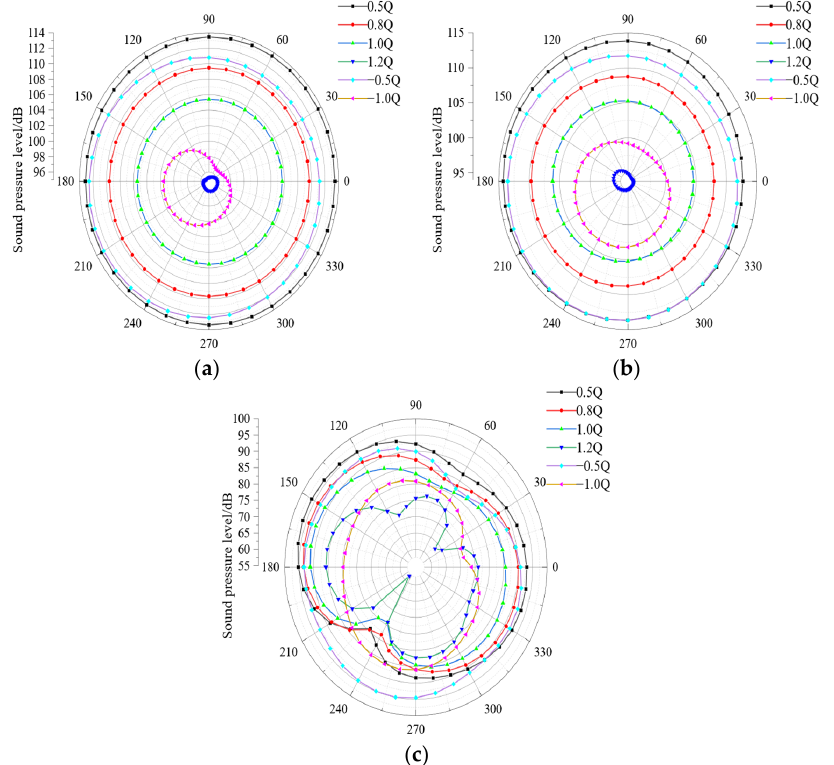
Figure 15. Noise directivity distribution. ( a ) First ‐ order. ( b ) Second ‐ order. ( c ) Third ‐ order.